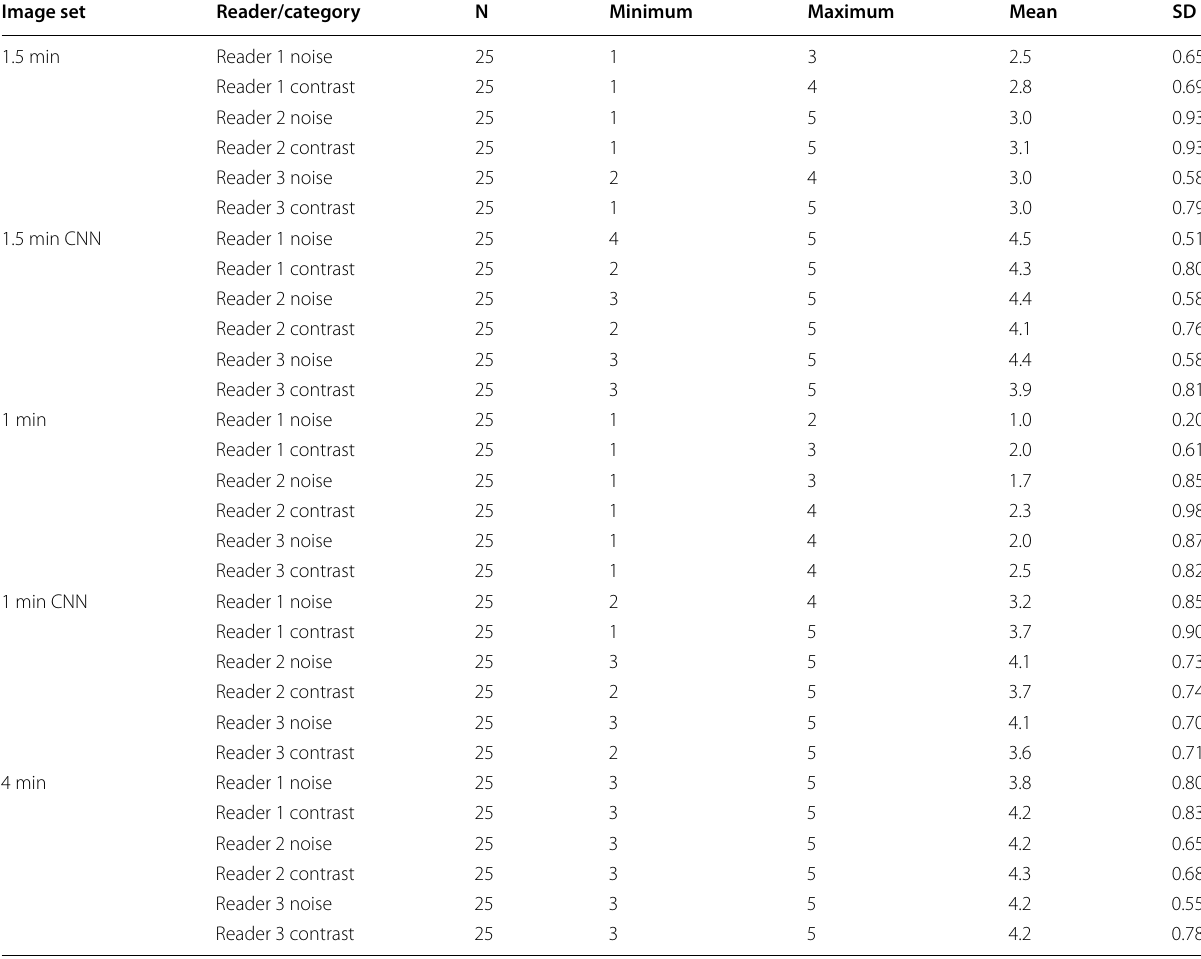
Table 4 Reader score descriptives